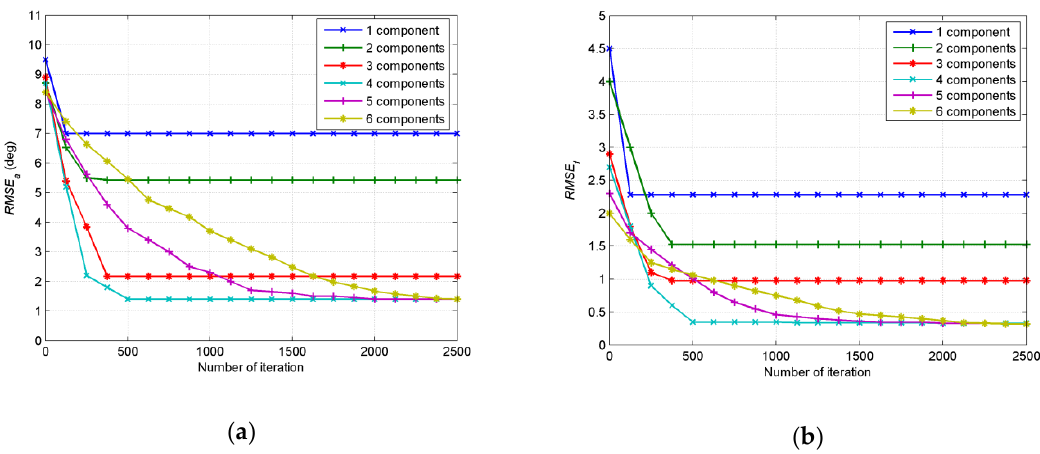
Figure 8. ( a ) RMSE a estimated by different number of Gaussian components; ( b ) RMSE f estimated by different number of Gaussian components .